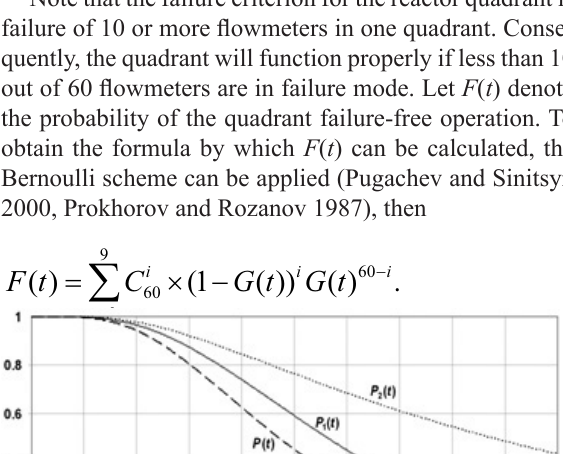
( t ) is the probability for 2